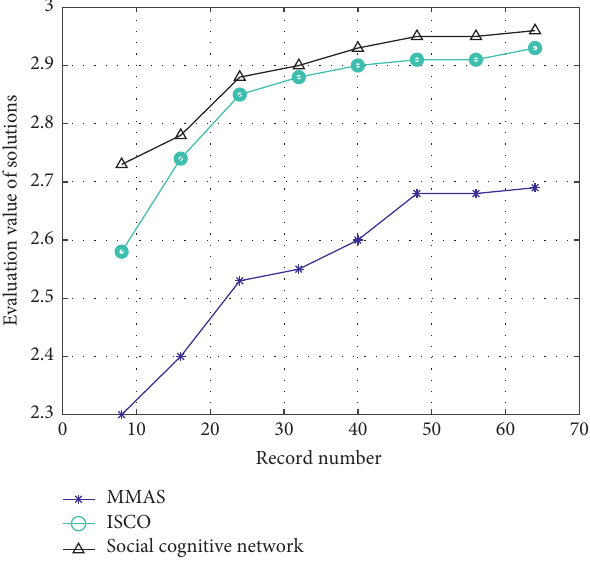
Figure 5: Comparison of search capabilities of the three